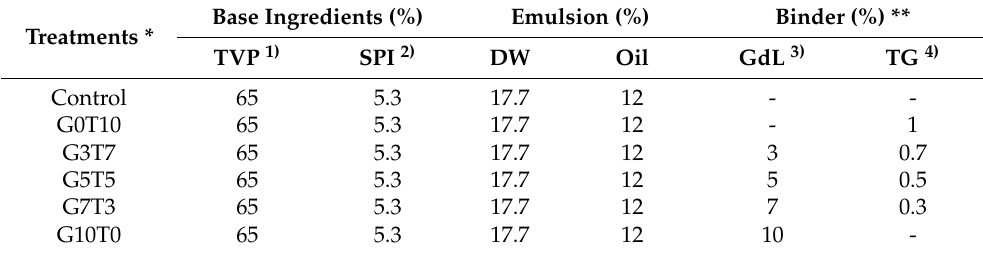
Table 1. Formulation ratio of ingredients for plant-based meat with different binders.